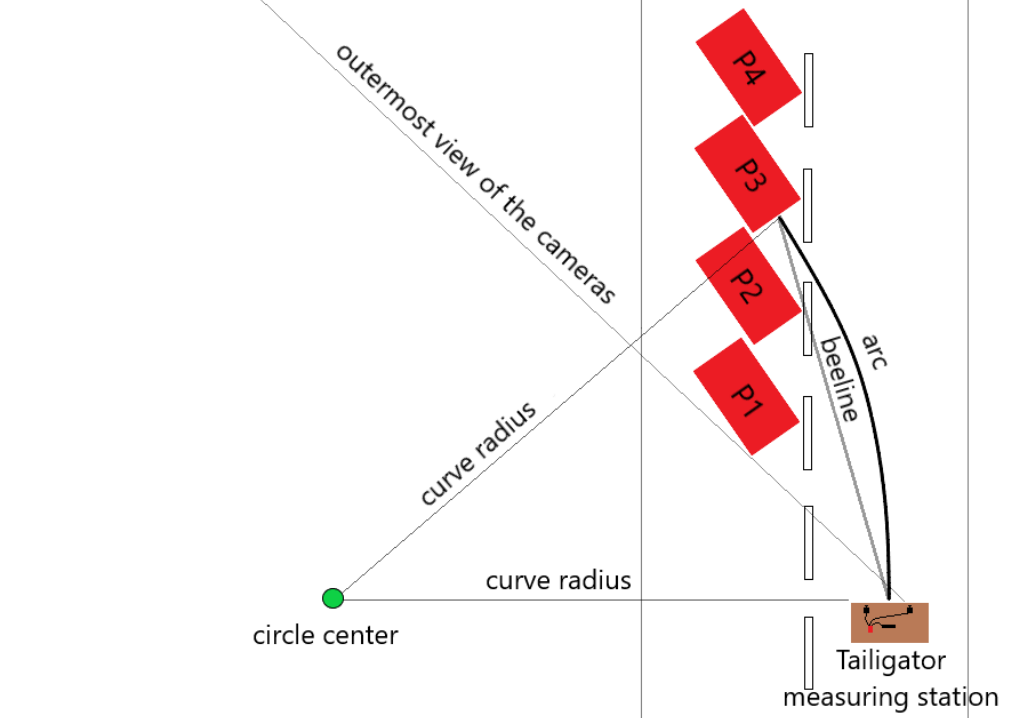
Figure 3. Graphic depicting the set up to measure with the four different car